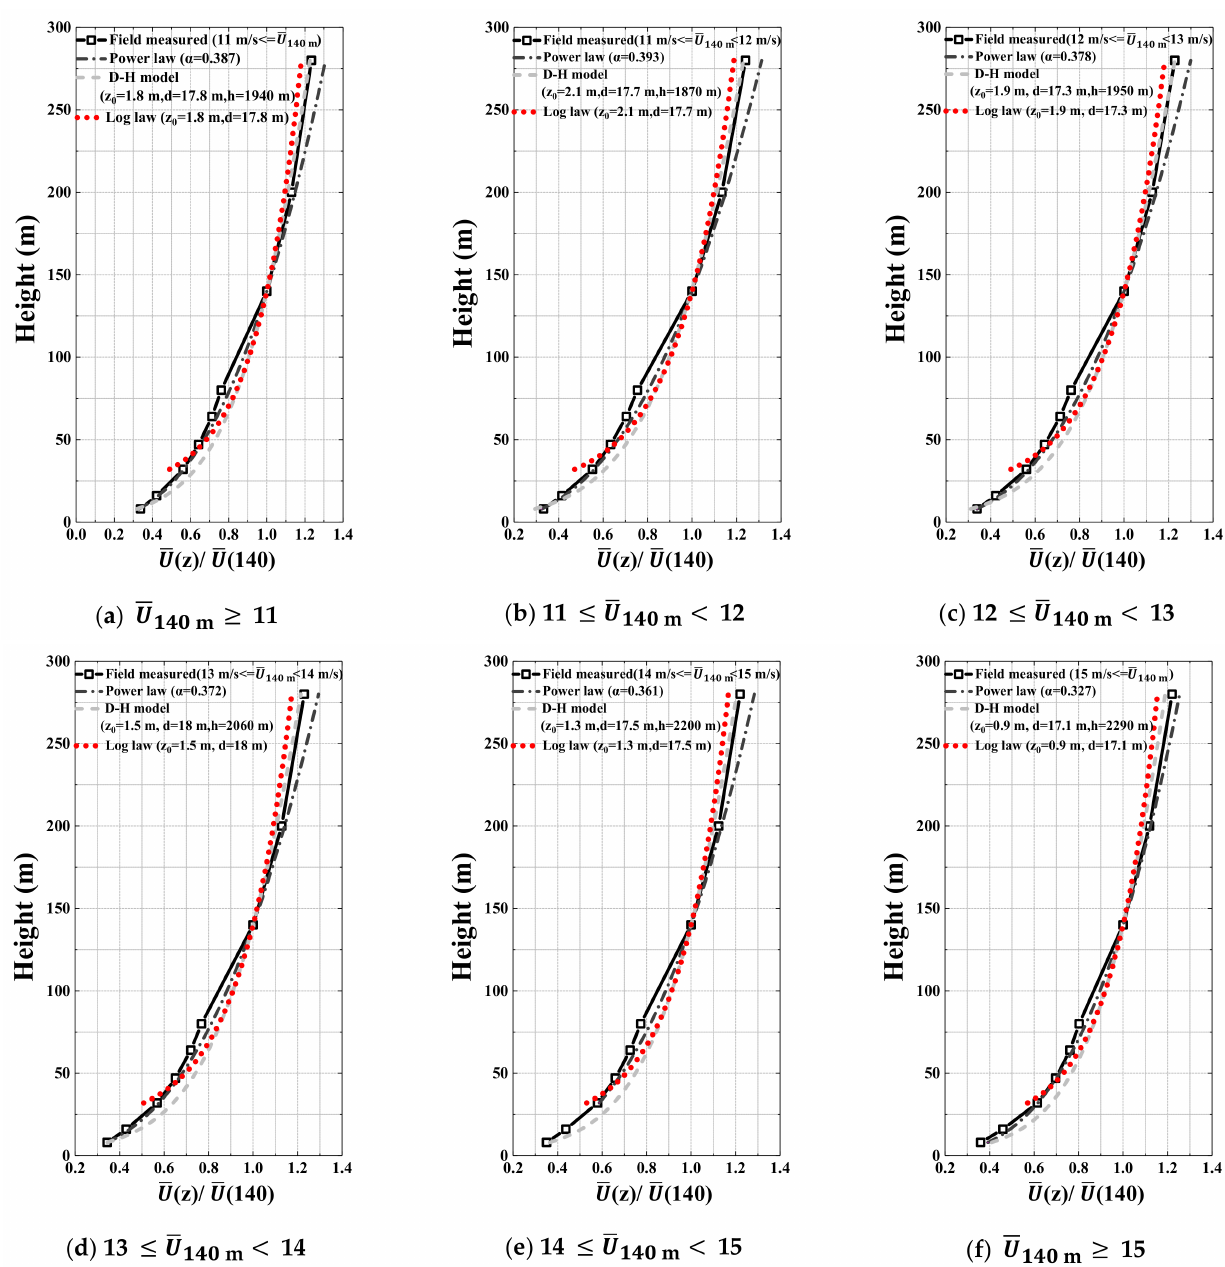
Figure 17. Comparison of the measured mean wind speed profile with those of the empirical models based on the adoption of the measured parameters related to wind records with different speed ranges